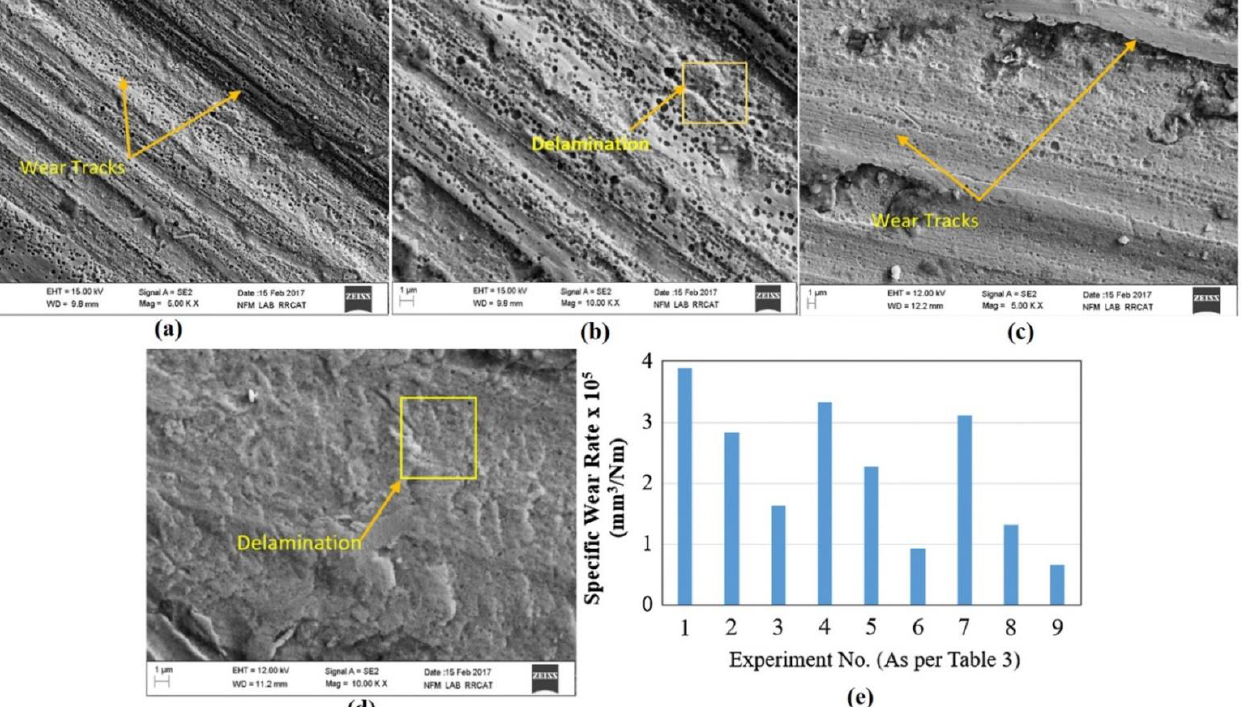
Figure 11. ( a , b ) Untreated LSP samples wear rates at lower and higher magnifications, respectively, and ( c – e ) treated LSP samples wear rates at lower and higher magnifications and an evaluation with the untreated samples, respectively [65]; with permission from Springer.